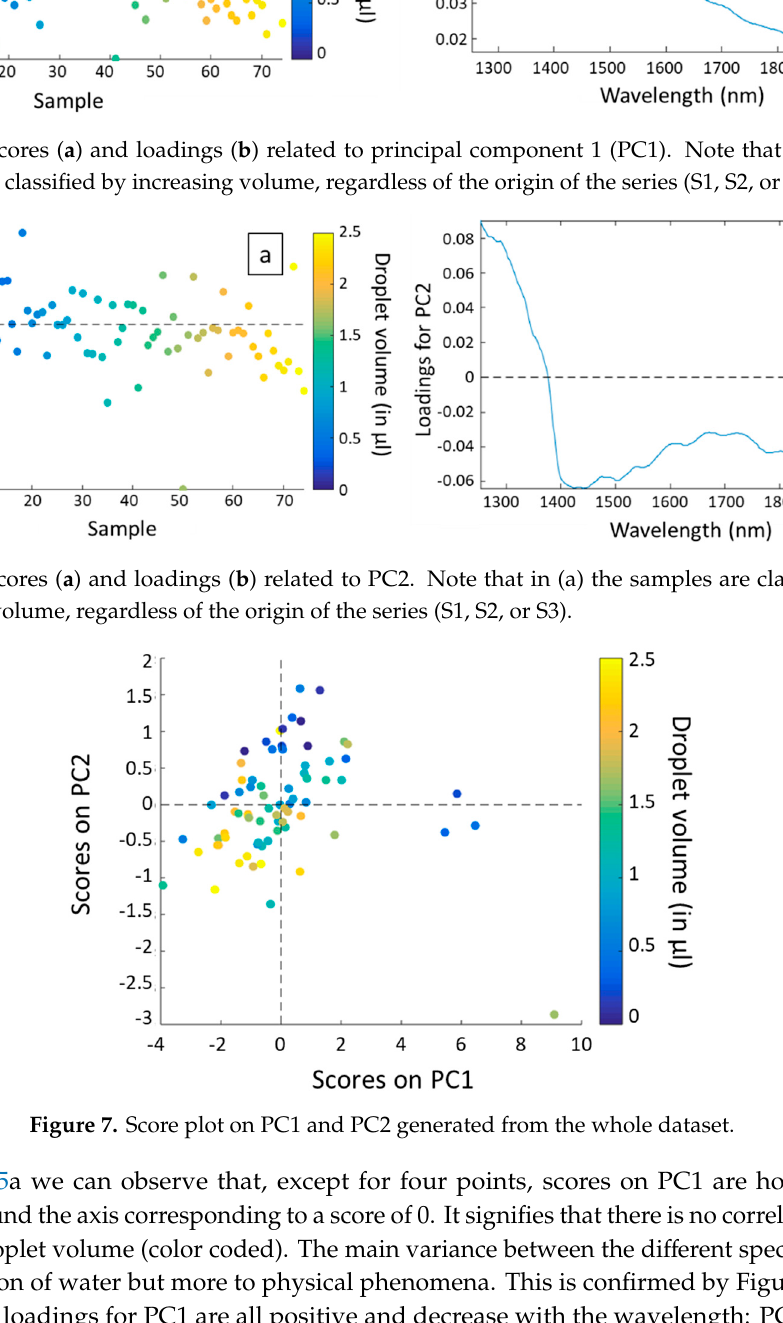
Figure 6. Scores ( a ) and loadings ( b ) related to PC2. Note that in (a) the samples are classified by increasing volume, regardless of the origin of the series (S1, S2, or S3).